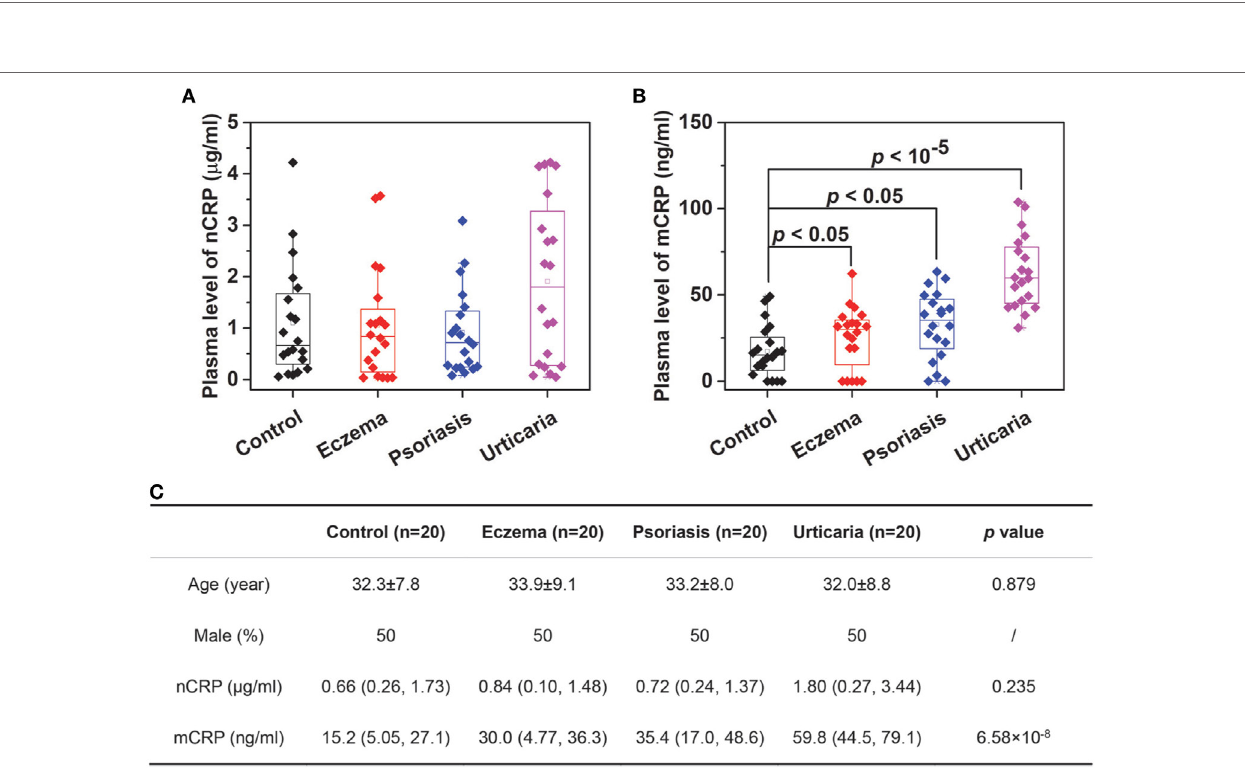
FigUre 3 | Determination of monomeric CRP (mCRP) levels in clinical samples. The plasma levels of native C-reactive protein (nCRP) (a) and mCRP (B) were determined in healthy controls ( n = 20) and patients with eczema ( n = 20), psoriasis ( n = 20), and urticaria ( n = 20) using Corning microtiter wells coated with 1:1,000 CRP-8. (c) The summarized